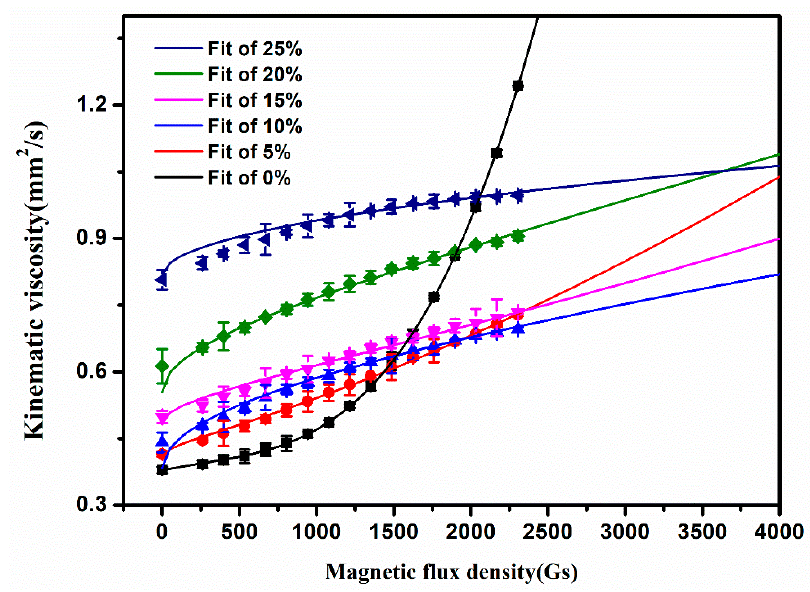
Figure 4. Relationship between magnetic flux density, Li 2 TiO 3 volume fraction, and kinematic viscosity. Table 1. η = A 1 B ^3 /2 + A 2 B ^1 /2 + A 3 fitting curve values.